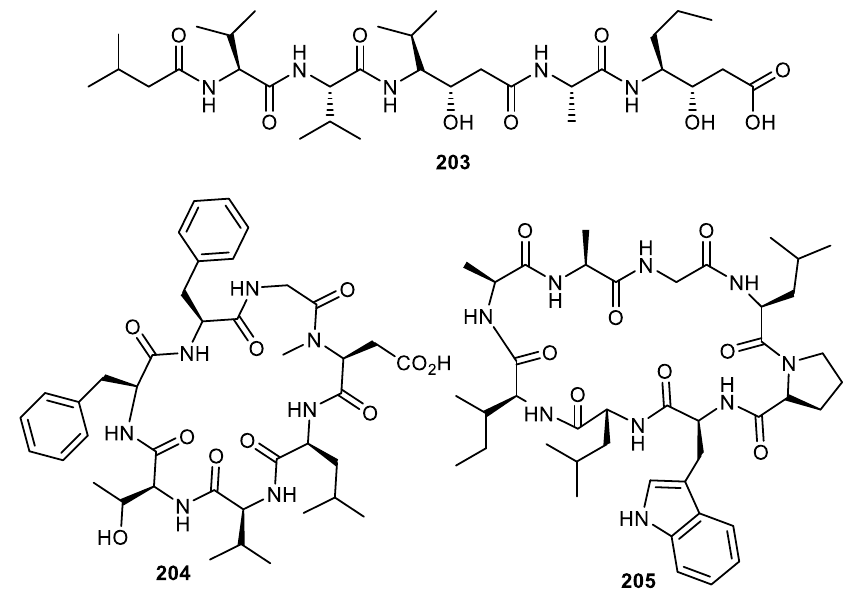
Figure 24. Structures of peptides 201 – 203 .